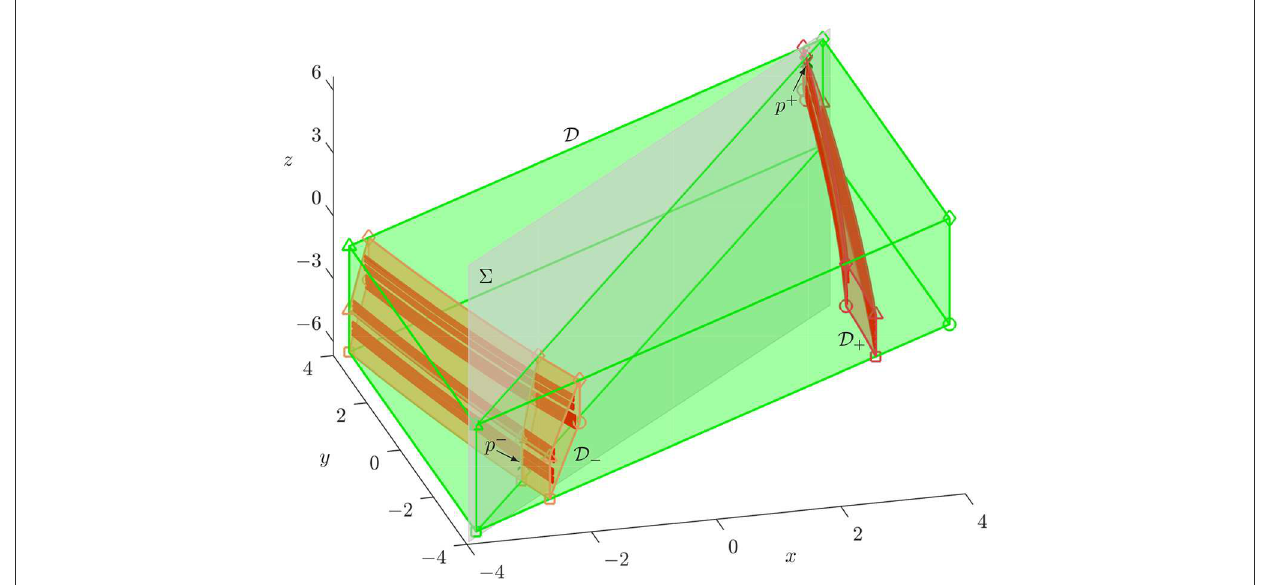
FIGURE10 Unstable manifolds W u ( p ± ) (red curves) of p ± (green crosses) for ξ = 0.4 inside the box D (green) and its two preimages D − (orange) and D + (red); shown are the first 450 segments of W u ( p ± ) ∩ B in ( x , y , z )-space together with the diagonal plane 6 (gray). Compare with Figure